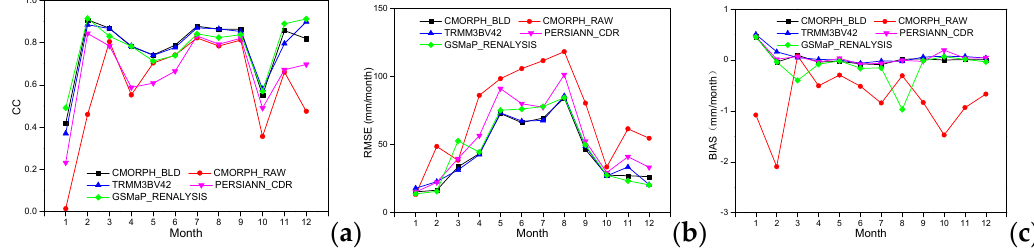
Figure 12. ( a – c ) denote the CC, RMSE and BIAS values of the studied products for each month in 2013 over southern China, respectively.